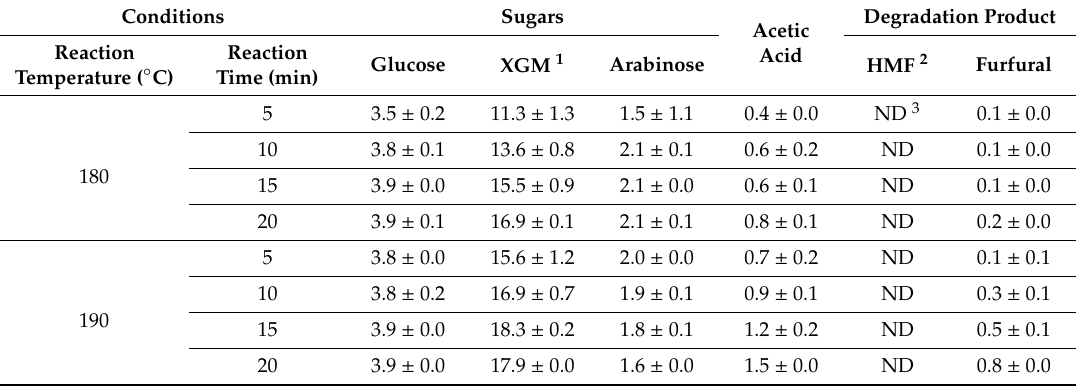
Table 3. Monomeric sugar composition of the liquid hydrolysate by reaction temperature and time